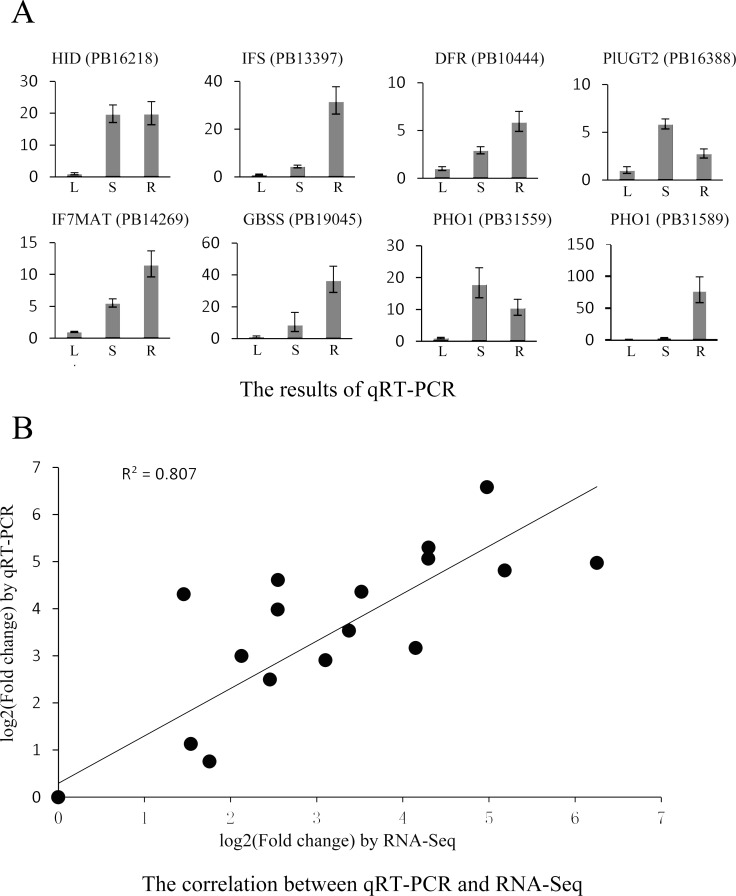
Expression profiles of 8 transcripts by qRT-PCR and the correlation of the results between qRT-PCR and RNA-Seq.Fold changes in the transcript levels of different tissues are shown in Fig 3A. The average expression levels in the plant leaves were set to 1. Error bars represent standard error. L, S and R represent the leaves, stems and roots, respectively. Fig 3B shows the correlation between the qRT-PCR and RNA-Seq expression levels. The X-axis represents log2-fold change in the expression levels found by qRT-PCR. The Y-axis indicates the log2 value of the expression level fold change from RNA-Seq.